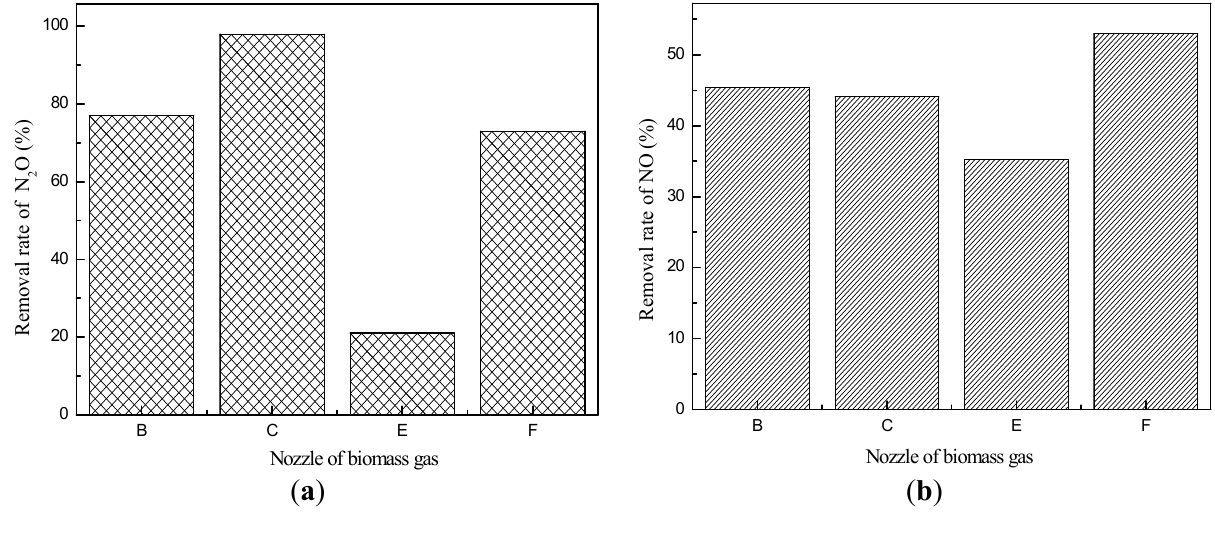
O and NO at different nozzles. ( a ) N 2